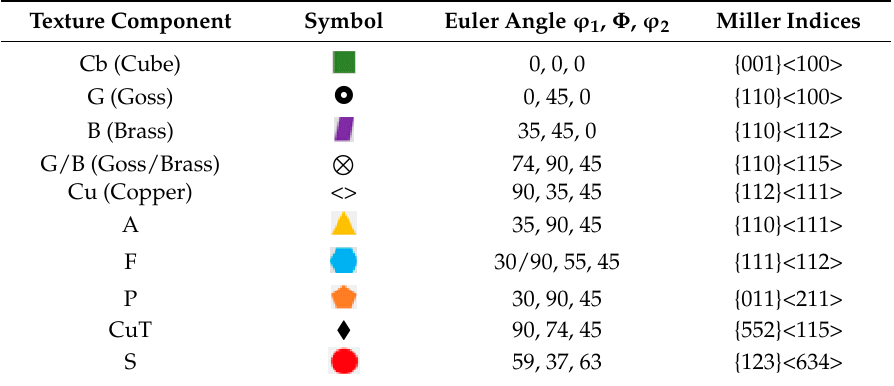
Figure 6. Orientation density function (ODF) section at φ 2 = 0°, 45° and 63° (right) at each analyzed deformation state and their respective IFP along rolling direction, red arrows indicate maximal intensity for orientation {111} and {001}. Horizontal and vertical bars, respectively, correspond to ODF and IFP maximal intensity. The red dashed line represent the α -fiber. The symbols for each texture component are, respectively, Cb: , G:  ,